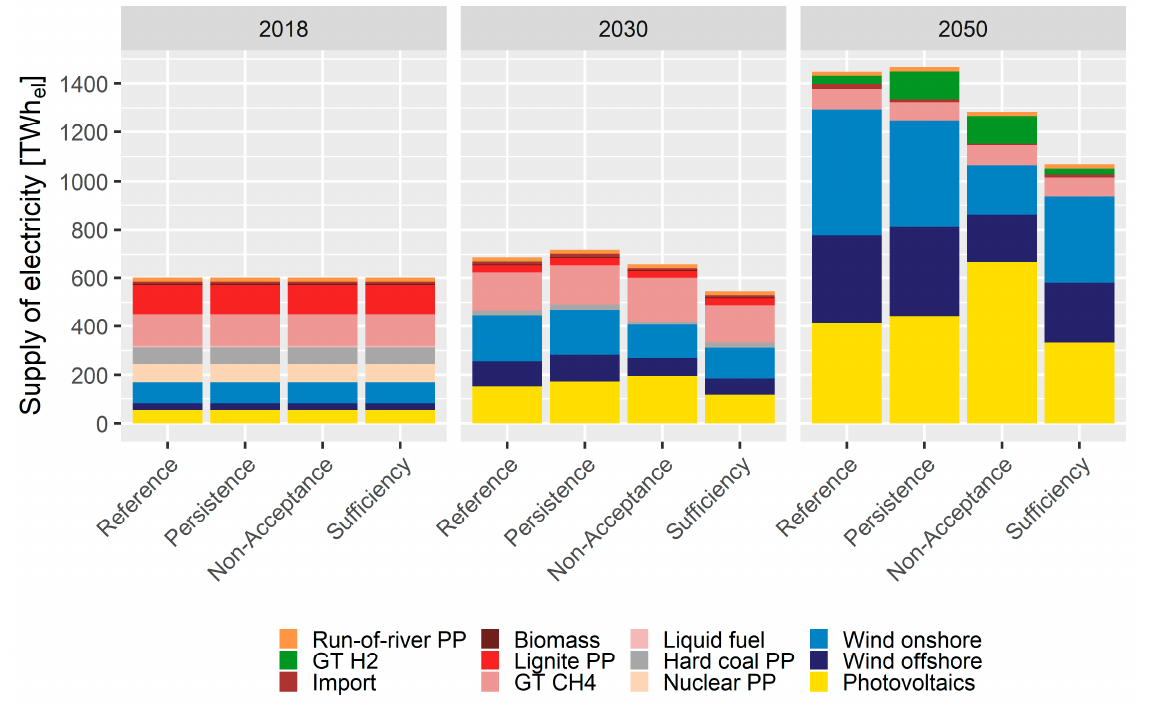
Figure 4. Electricity generation for 2018, 2030, and 2050 (results calculated with REMod).